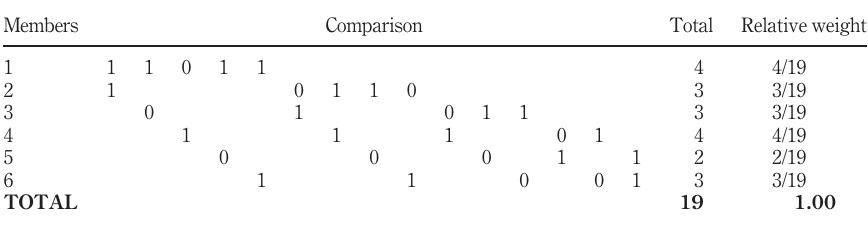
4. Relationship: Table 4 Paired comparison chart of each member on 'Relationship'.